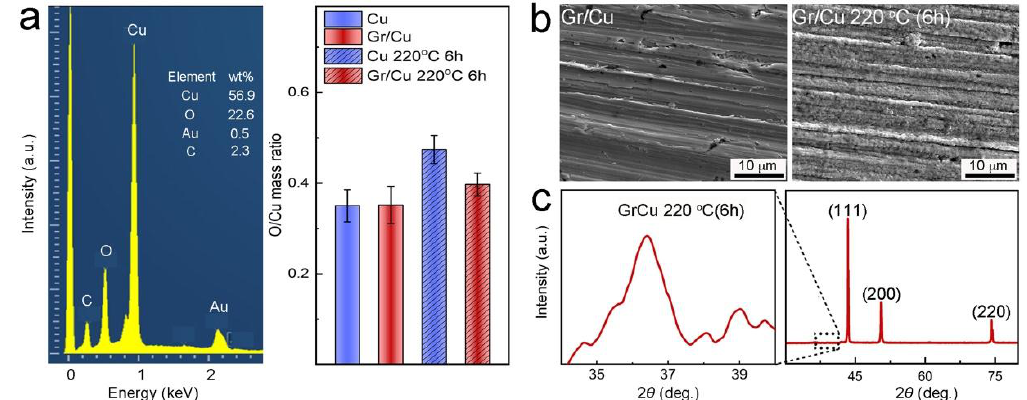
Figure 3. ( a ) A typical energy dispersive spectroscopy (EDS) spectrum of Gr/Cu composites after treatment and oxygen content analysis from EDS measurements. ( b ) SEM images and ( c ) XRD pattern of Gr/Cu composites after